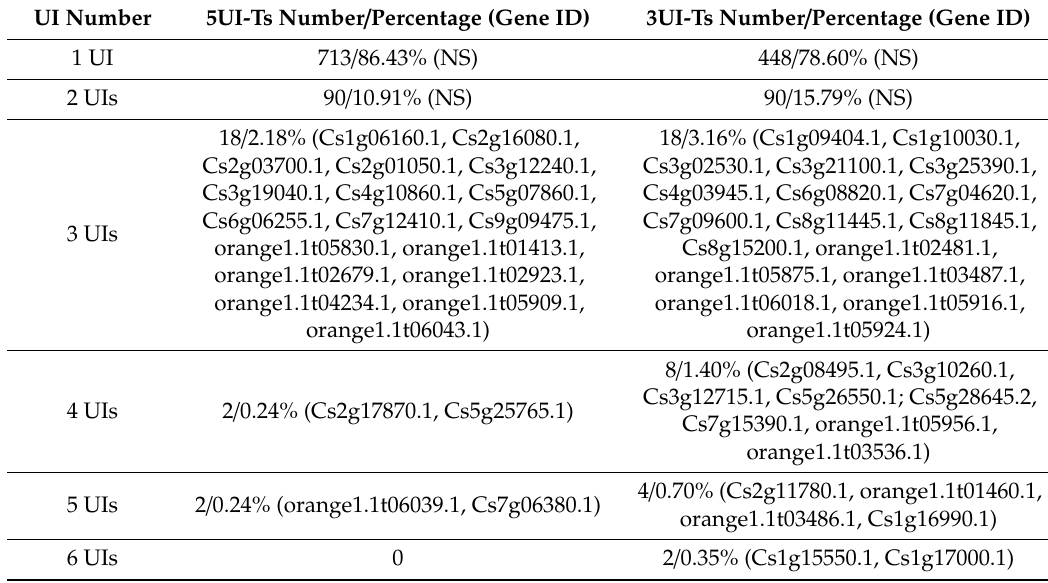
Table 2. Information of the UTR-intron (UI) numbers in the 5UI and 3UI containing gene transcripts (respectively abbreviated as 5UI-Ts and 3UI-Ts). 1 UI~6 UIs respectively means that there is 1~6 UIs present in the UTR. There are a total of 825 gene transcripts containing 5UI, and a total of 570 gene transcripts containing 3UI. NS: not